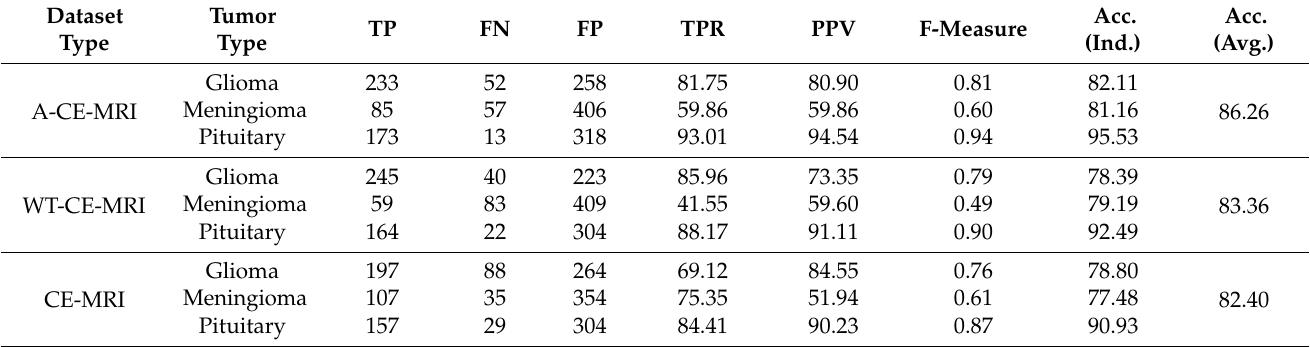
Table 7. Analysis of input layer size on the proposed model using SVM in the test phase (A-CE-MRI dataset, OvA coding scheme, and polynomial kernel ( P 3 )).